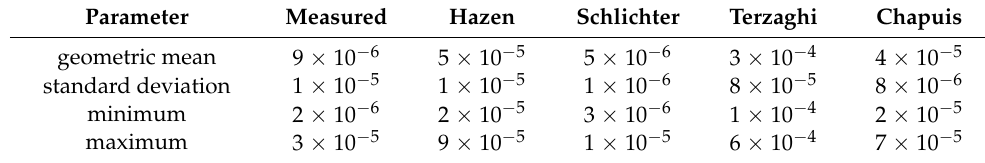
Figure 3. Frequency histograms for Type I deconstruction S (wt.%), C (wt.%), K S (m s − 1 ), Ln(S) , Ln(C) , and Ln(K S ) and quantile–quantile plots for Ln(S) , Ln(C) , and Ln(K S ) . The dashed line on the histo- grams represents the normal distribution calculated from the population mean and standard devi- ation; the solid line on the quantile–quantile plots represents the log-normal distribution . 3.3. Stationarity To characterize the spatial dependence of the Type I deconstruction data set, the as- sumption of stationarity in the first two moments (mean and variance) for Ln(S) , Ln(C) , and Ln(K S ) was considered. Stationarity is defined in this context as the absence of signif- icant trends in mean and variance of the analyzed parameters with depth in the test-pile